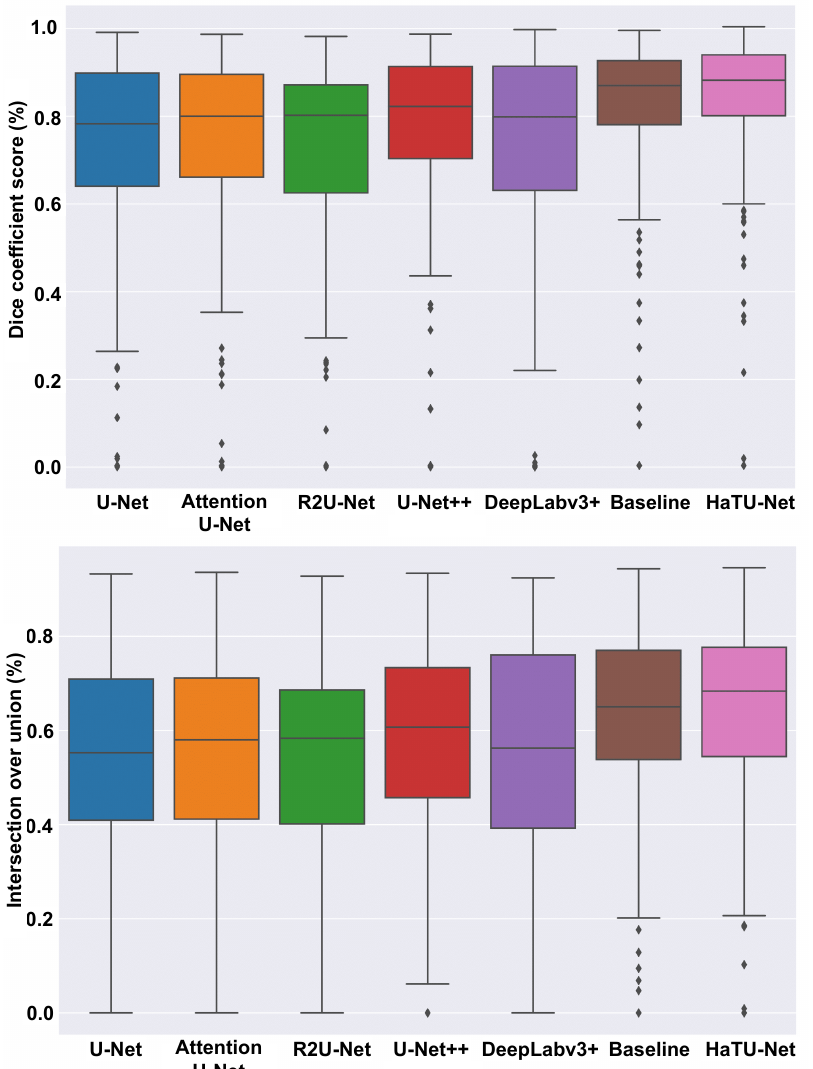
Figure 7. Boxplots of Dice and IoU scores of follicle segmentation.